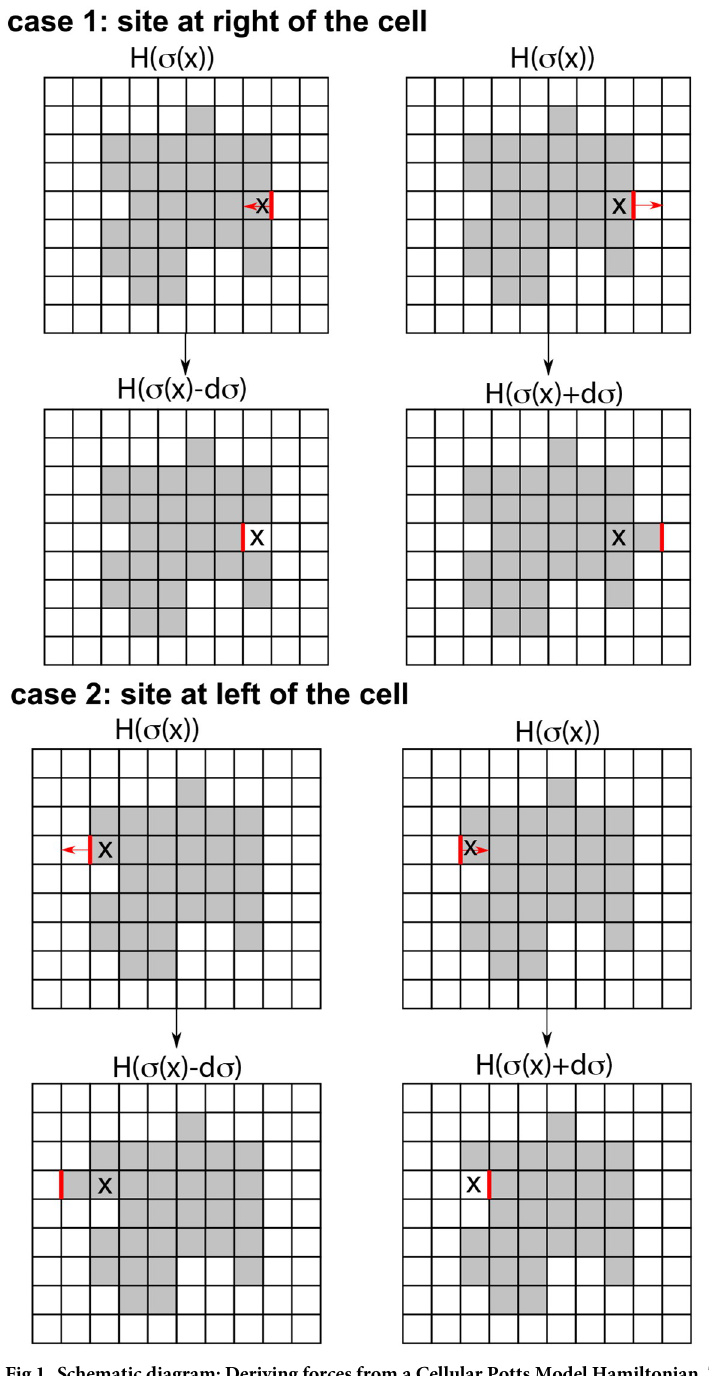
Fig 1. Schematic diagram: Deriving forces from a Cellular Potts Model Hamiltonian. The Hamiltonian represents an energy, so ~ F ¼ (cid:0) r H . We compute a discrete approximation to the components of the force ( F on the cell boundary. Centered finite differences are used to approximate the derivatives − ( @ H / @ x , @ H / @ y ) of the Hamiltonian as in Eq (0.5). Here we illustrate the idea for the x component of the force, F cell configuration σ (top row), we numerically compute the difference in the Hamiltonian at a point ~ x on the right cell boundary when the cell retracts or extends (second row). We show the same idea for the left cell boundary (last two rows). The force field computed along the boundary is then smoothed and interpolated to the cell interior, as described in Materials and